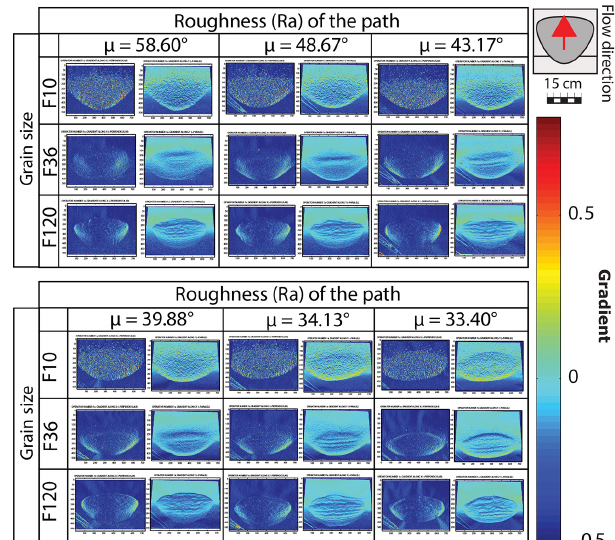
Figure 7. Results of the gradient along x and y applied to all ex- periments carried out for this research. The best results are obtained with the gradient along y . The influence of the grain size and the substratum on the shape of the deposit is clearly